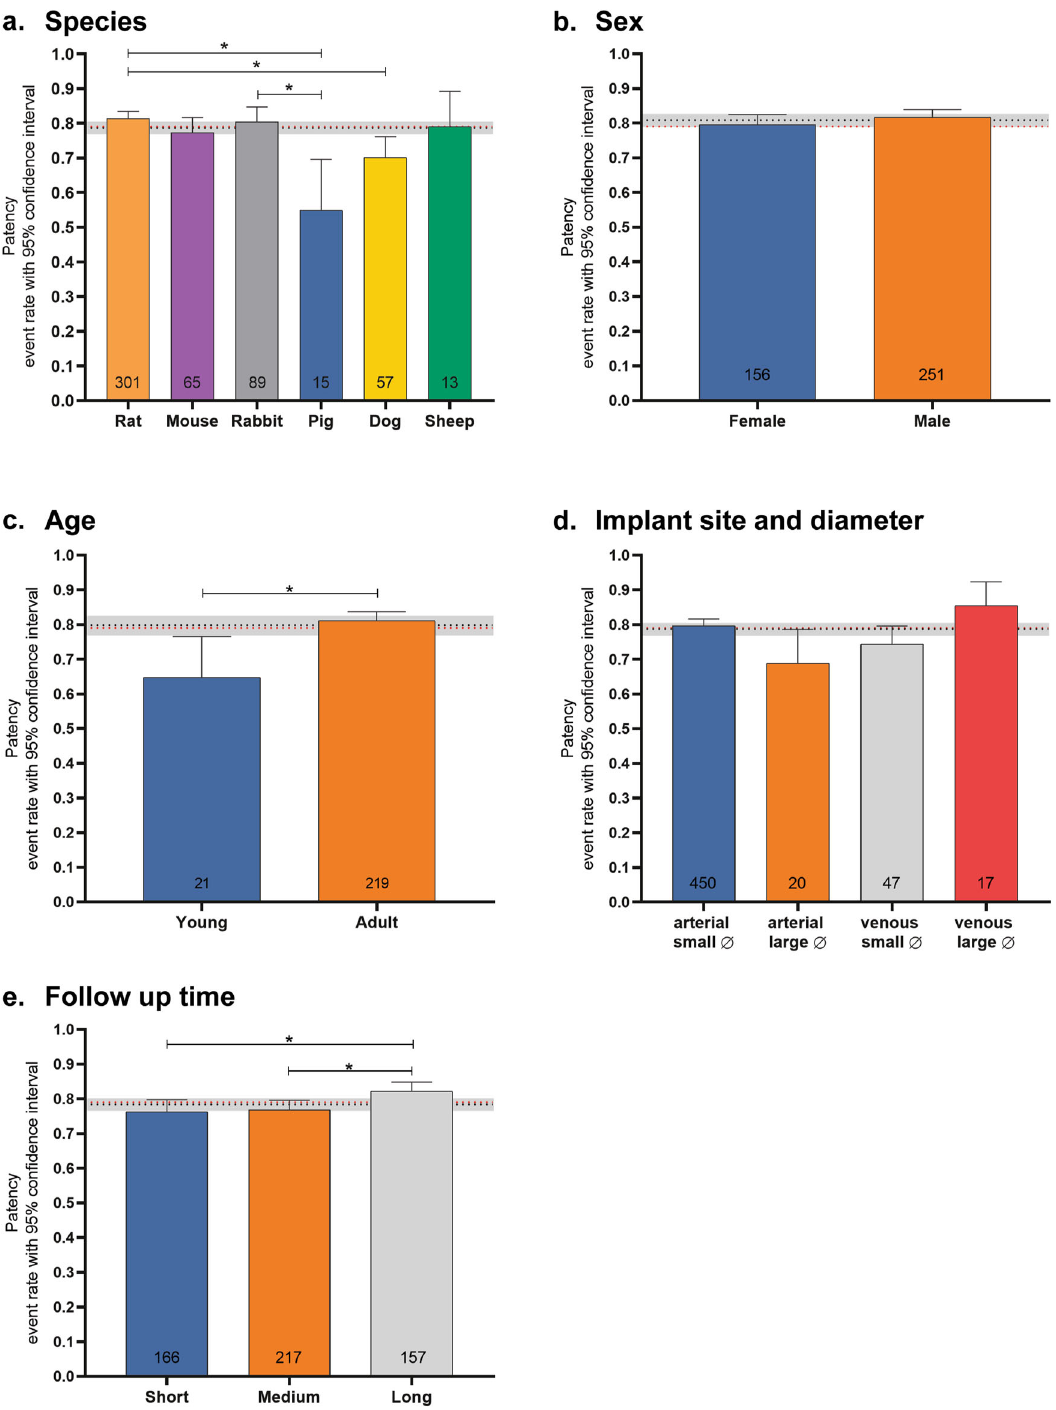
Fig. 9 Meta-Analysis and subgroup analyses. a Subgroup analysis for species, b sex, c age, d implant site and diameter, and e follow-up time. Age and follow-time subcategorization are species-dependent; see Table 1 for cut-off values young vs adult ( c ) and short vs medium vs long ( e ) per species. Numbers in bar represent number of experimental groups. Black dotted line and gray shades representing grouped ER with 95% CI respectively. Red dotted line: overall ER patency. Signi fi cance * p <